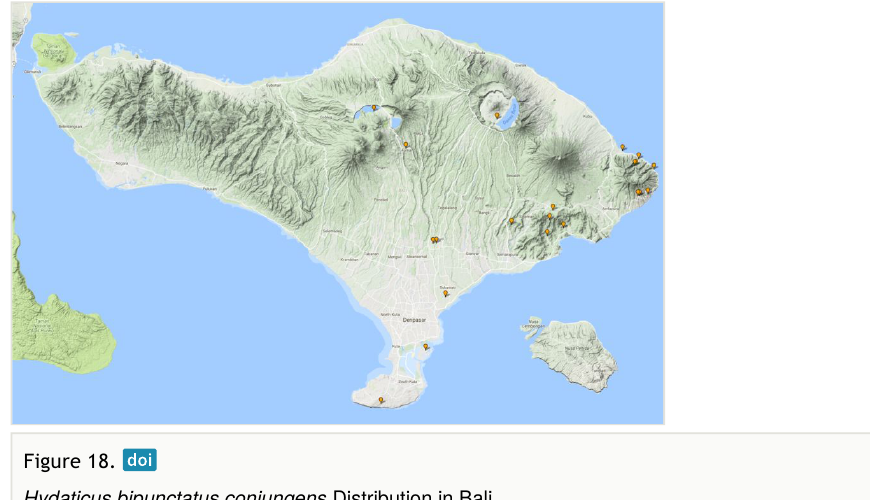
Hydaticus bipunctatus conjungens Distribution in Bali.